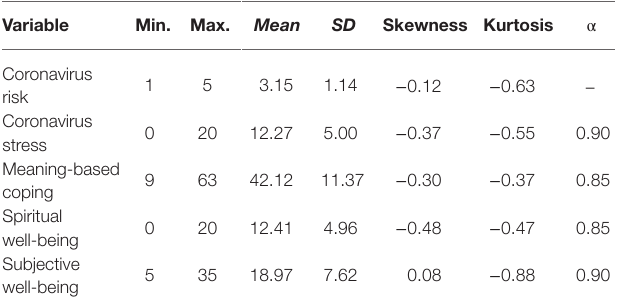
TABLE 1 | Observed scale